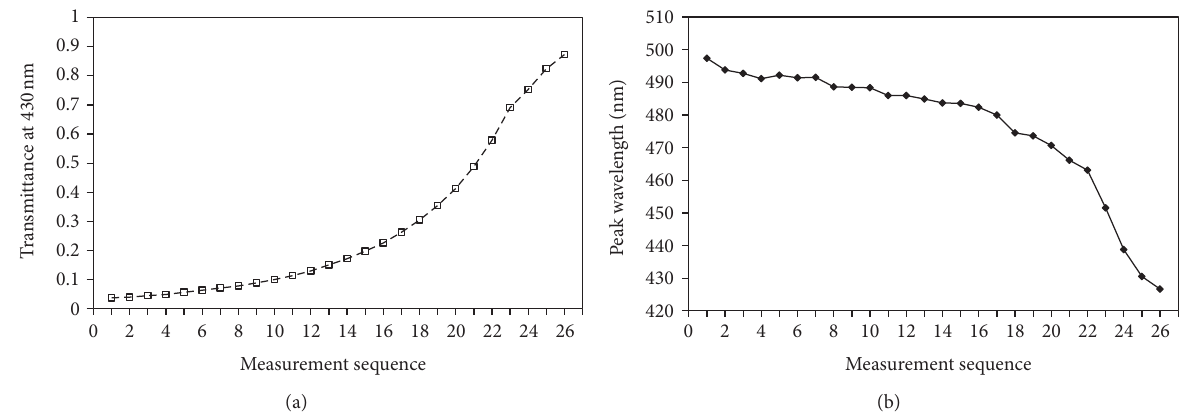
F 6: (a) e transmittances at 430nm of 26 measurements for the negative electrolyte in Figure 5; (b) the peak wavelength within the measurement range (420nm–600nm) of the spectra of the 26 measurements for the negative electrolyte in Figure